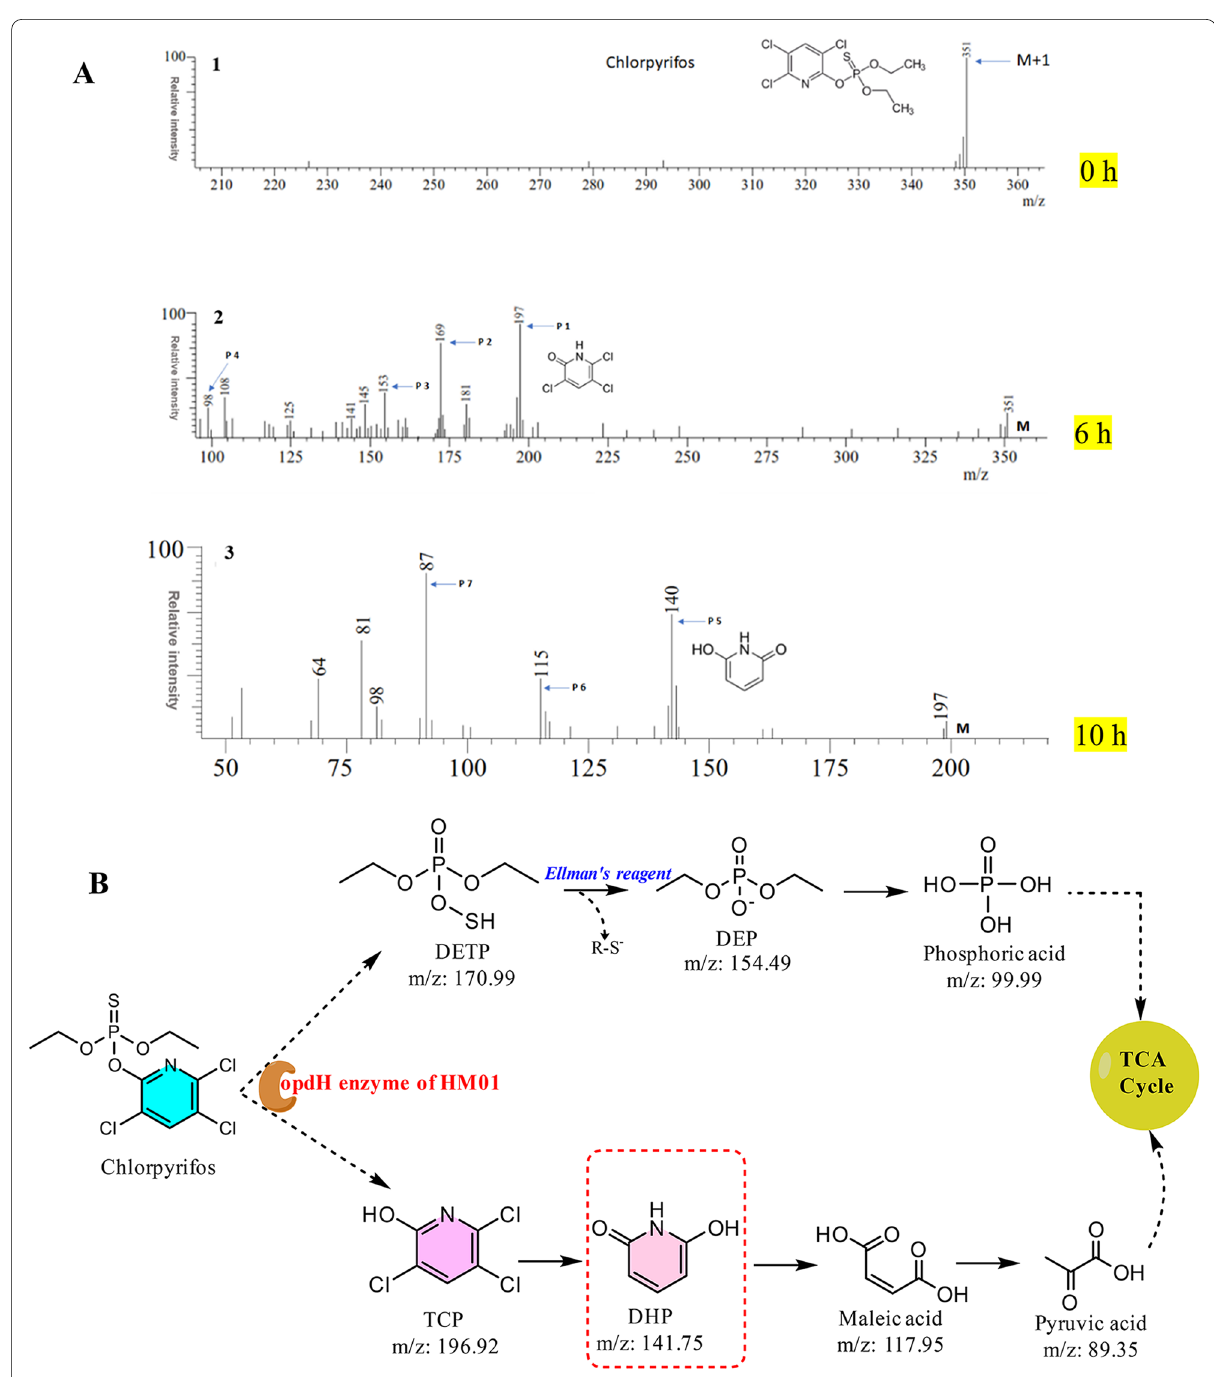
Fig. 5 A Mass spectra of chlorpyrifos (CP) metabolites in the degradation process, wherein (P1) was TCP, (P2) DETP, (P3) DEP, (P4) H3PO4, (P5) DHP, (P6) cis -2-butenedioic acid, (P7) pyruvic acid, B proposed CP degradation pathway by isolate HM01, where all metabolites were sequentially arranged with m/z value, releasing of thiol group from DETP was measured by Ellman’s reagent, and red dotted box represents new metabolite observed in CP degradation